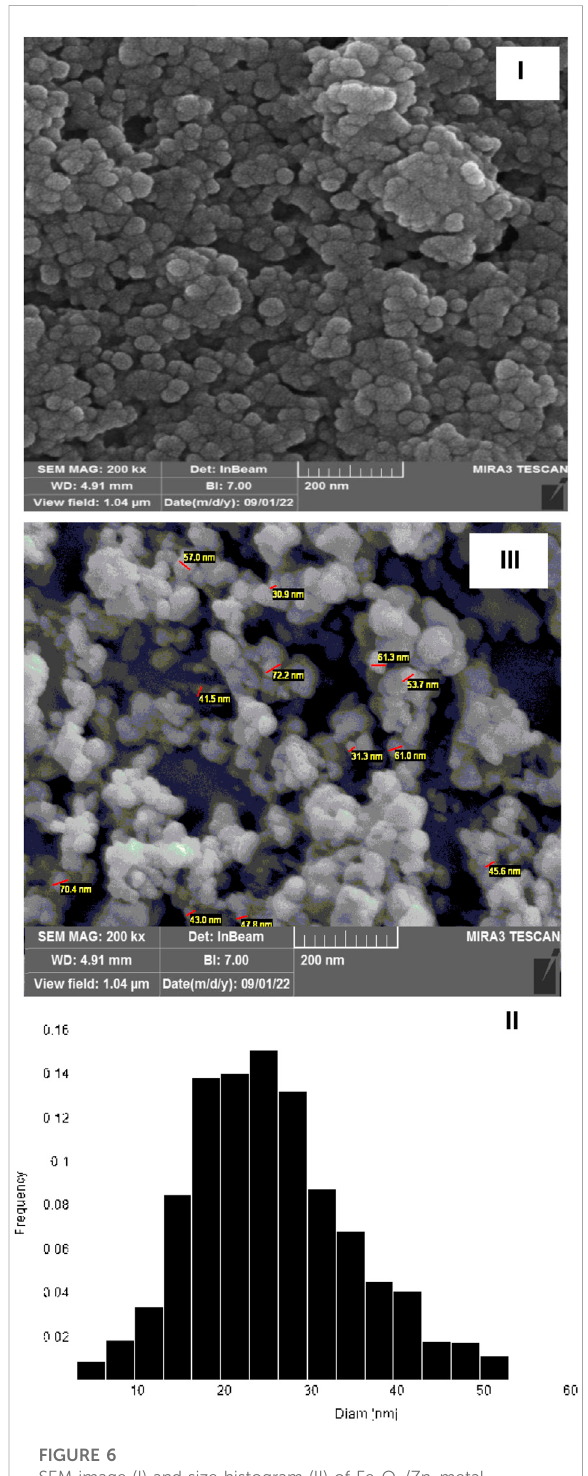
FIGURE 6 SEM image (I) and size histogram (II) of Fe 3 O 4 /Zn-metal organic framework magnetic nanostructures and SEM image of Fe 3 O 4